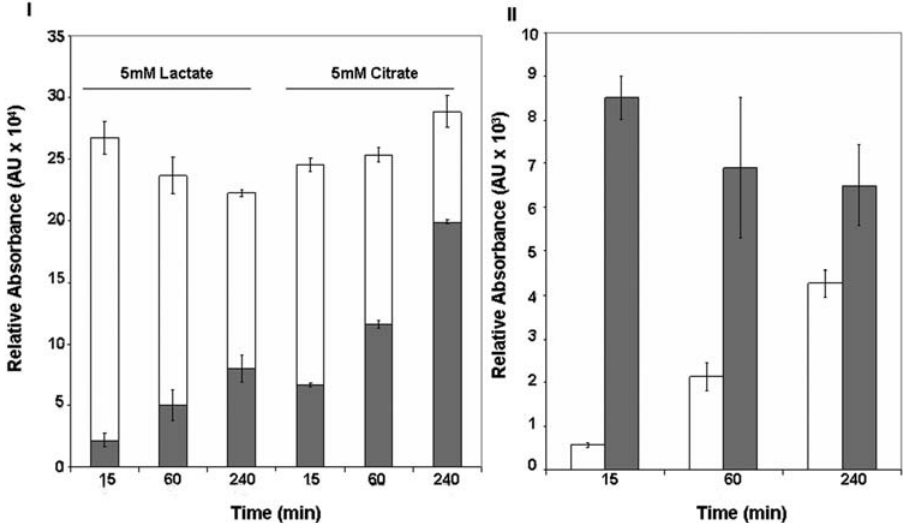
Figure 3. Lactate as a source of mitochondrial energy in an astrocytic cell line. Mitochondria were incubated with 5 mM lactate or 5 mM citrate, 0.1 mM NAD + , and 0.1 mM ADP for varying time intervals. Nucleotide levels were measured by HPLC using a C 18 reverse phase column. I) ATP/ADP ratio in mitochondria. Open bar % =ADP, and closed bar & =ATP II) NAD + /NADH ratio in mitochondria incubated with lactate. Open bar % =NADH, and closed bar & =NAD + . Peaks were confirmed by utilizing known standards and by spiking the samples. n=3, mean 6 SD